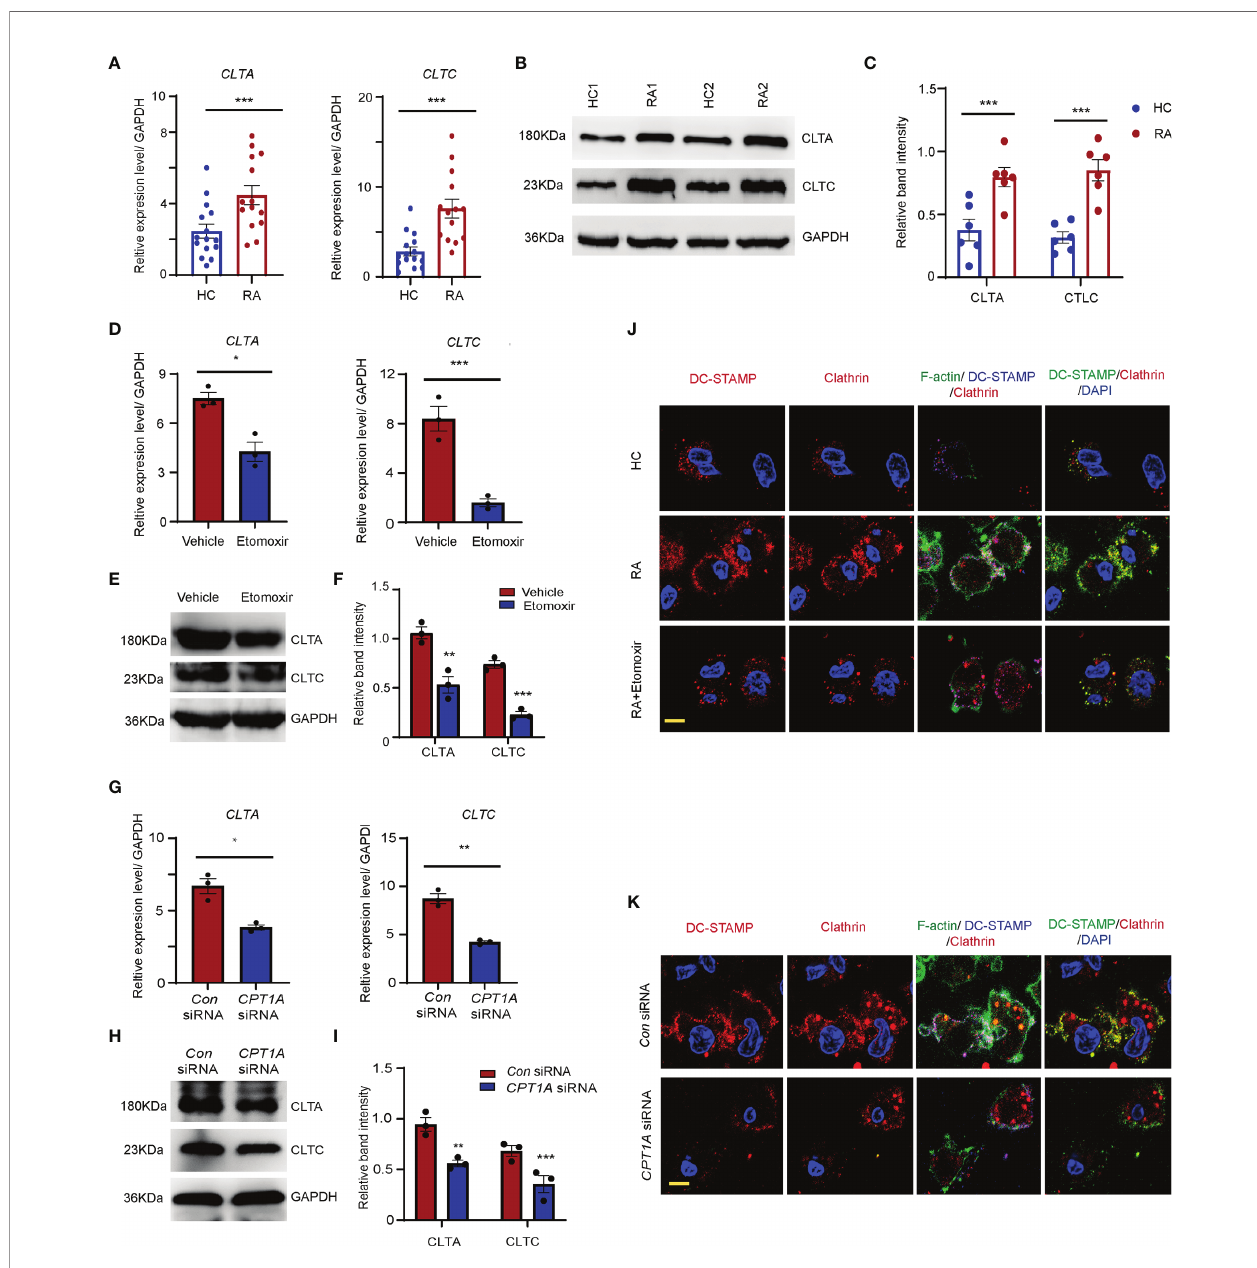
FIGURE 5 | CPT1A promotes OCP fusion through upregulating clathrin dominant endocytosis. CD14 + monocytes were isolated from HCs and RA patients. (A) Clathrin light chain A ( CLTA ) and clathrin heavy chain ( CLTC ) expression was quanti fi ed by qPCR in monocytes from RA patients and HCs. The results from 3 independent experiments involving 14 RA patients and 15 HCs are shown. (B, C) Representative blotting for CLTA and CLTC protein expression. The band intensities were adjusted to GAPDH. The western blotting experiment results analyzing 8 RA patients and 8 HCs are shown as the mean ± SEM at (C) . (D – F) CD14 + monocytes were treated with DMSO or 25 m M etomoxir at day 2 after M-CSF and RANKL stimulation. (D) CLTA and CLTC gene expression was quanti fi ed by qPCR. The results from 3 independent experiments. (E, F) Representative blotting for CLTA and CLTC. The band intensities were adjusted to GAPDH. The western blotting experiment results analyzing 3 RA patients are shown at (F) . (G – I) CD14 + monocytes were transfected with control or CPT1A -speci fi c siRNA after M-CSF and RANKL stimulation at day 2. (G) CLTA and CLTC gene expression was quanti fi ed by qPCR. The results from 3 independent experiments. (H, I) Representative blotting for CLTA and CLTC. The band intensities were adjusted to GAPDH. The western blotting experiment results analyzing 3 RA patients are shown at (I) . (J, K) Monocytes were labelled with FITC – phalloidin staining (green) and DC-STAMP antibody (blue). Podosome structures were determined with co-staining with clathrin (red) antibody in HC, RA, and RA treated with 25 m M etomoxir (J) ; or in RA patients transfected with control or CPT1A -speci fi c siRNA (K) . Representative images are from one of three HC and RA patients. Bar, 10 m m. Data are representative from three independent experiments is shown. All data shown as the mean ± SEM. * P < 0.05; ** P < 0.01; *** P <